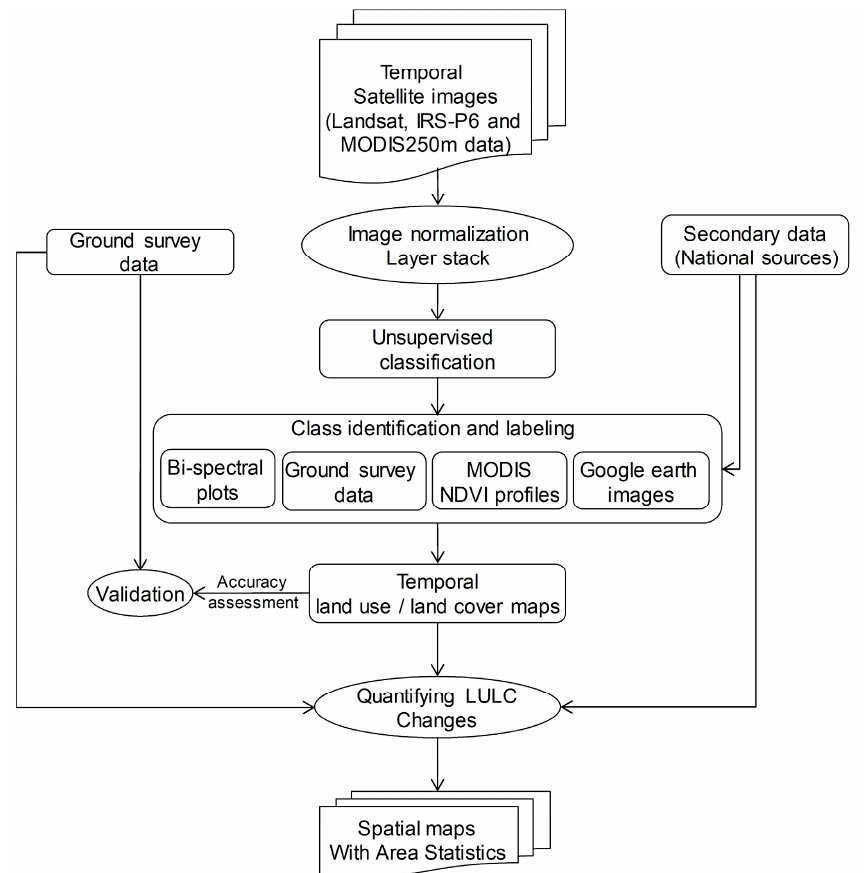
Figure 2. An overviews of the methodology used to map urban areas and other land-use/land-cover (LULC) changes using Landsat-8 data.